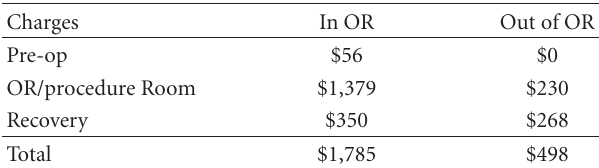
Table 5: Procedure e ffi cacy and safety.